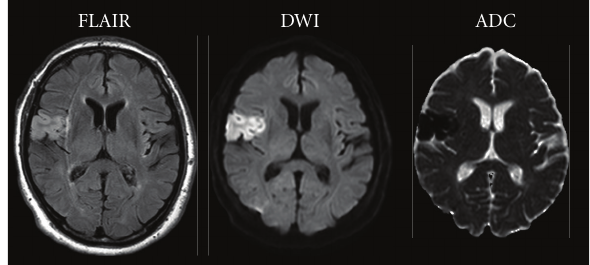
Figure 6: Case 2: follow-up MRI with FLAIR, DWI, and ADC showing an established infarction in the right frontal lobe matching the CTP-delineated ischemic